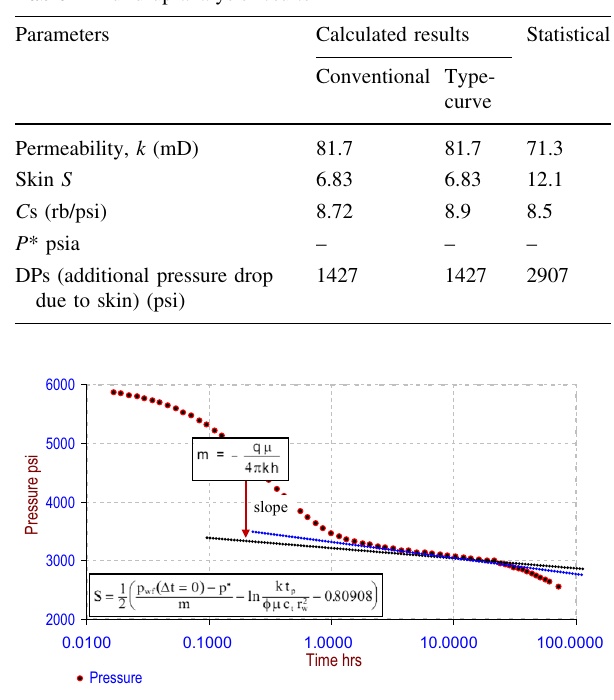
Table 2 Build-up analysis results